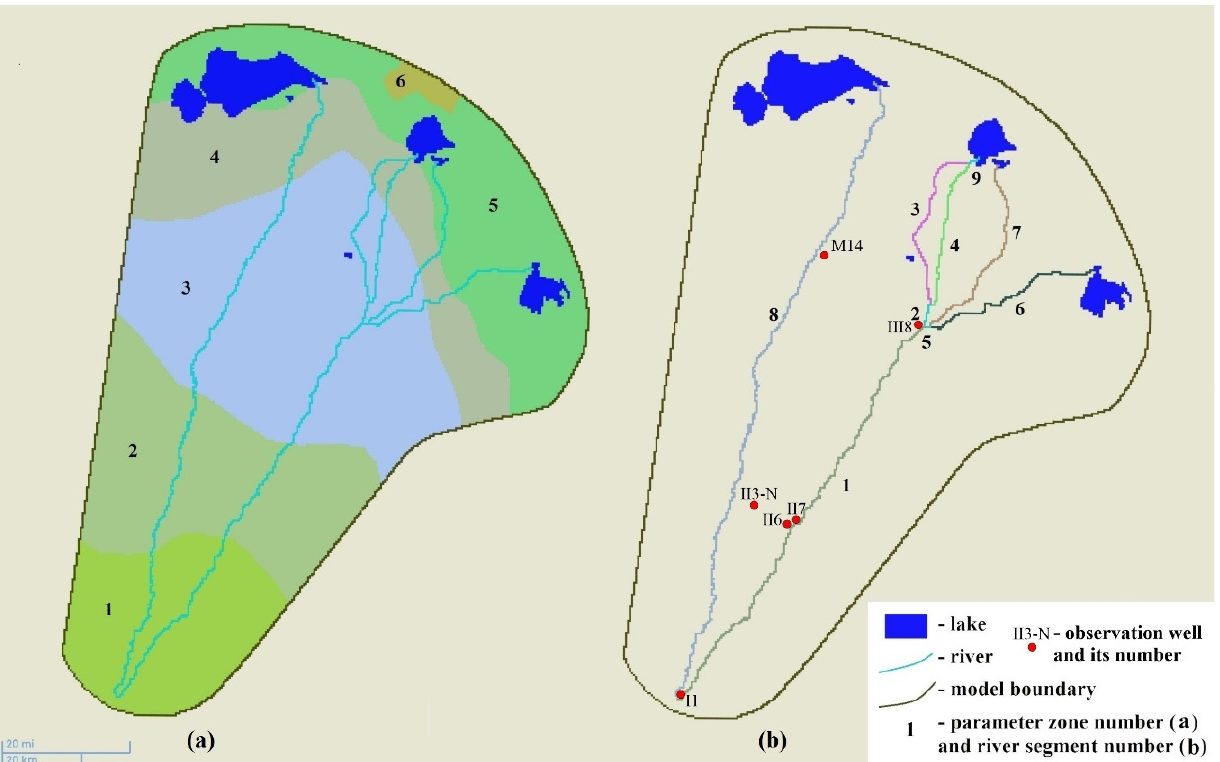
Figure 7. Distribution of the aquifer system hydraulic parameter zones ( a ) and division of river channels into segments ( b ). Table 2. Initial and calibrated values of the hydraulic parameters for the Ejina water balance model (The parameter zones are presented in Figure 7).